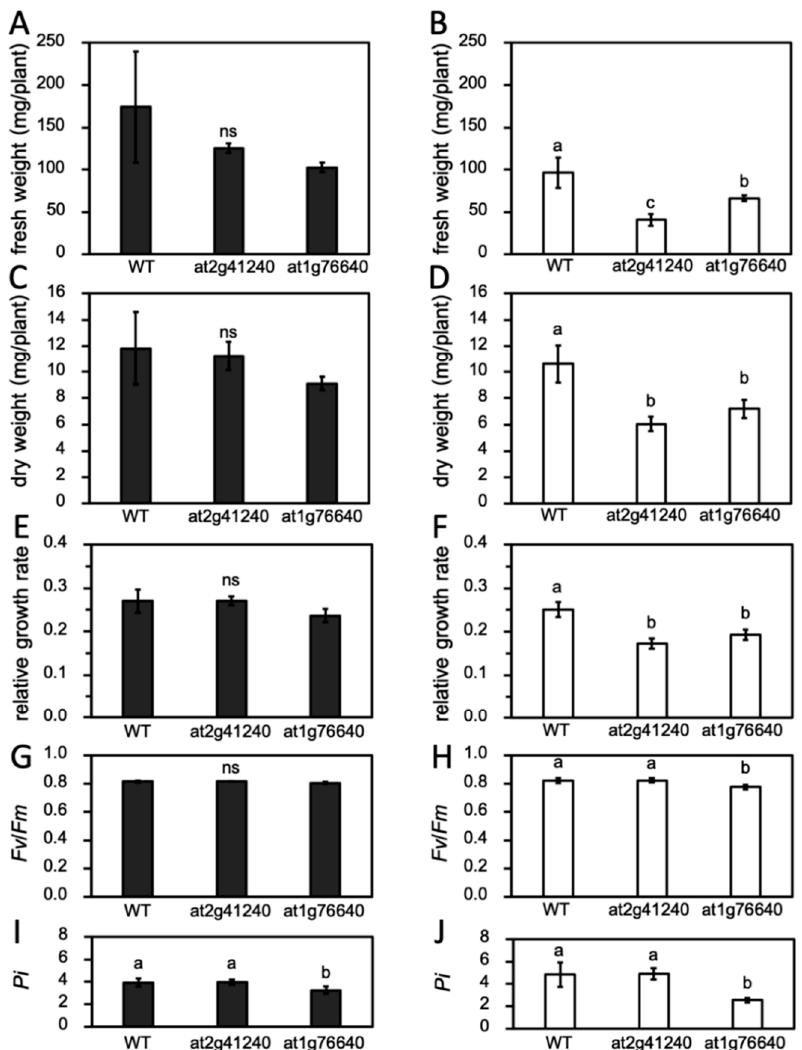
Figure 9. Phenotype of the Arabidopsis wild type (WT) and mutant under normal and salt stress conditions (250 mM NaCl) at 7 days after treatment in saline soil. Fresh weight ( A , B ), dry weight ( C , D ), relative growth rate ( E , F ), PSII maximum e ffi ciency ( F v / F m ) ( G , H ), and performance index ( P i ) ( I , J ) of Arabidopsis WT, at2g41240 , and at1g76640 mutants under normal (represented with black bars) and 250 mM NaCl salt stress condition (represented with white bars). Di ff erent letters represent significant di ff erences between groups ( p < 0.05) and ns means no significant di ff erence among means. Vertical bars represent standard